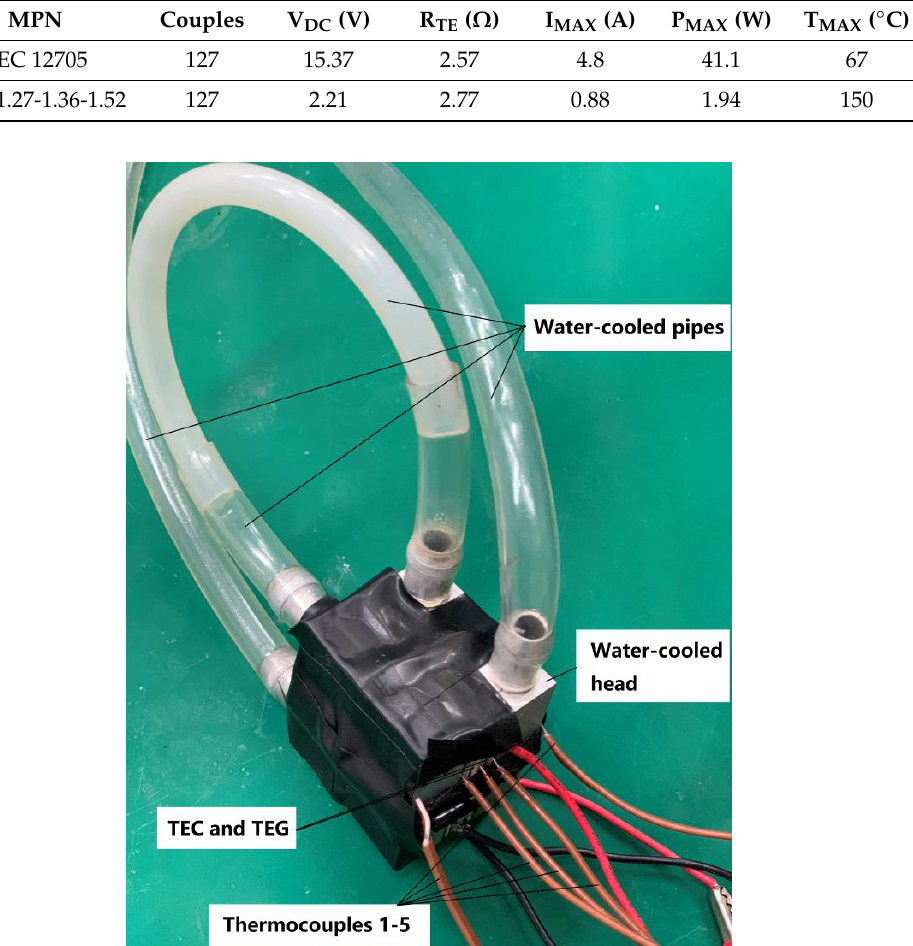
Figure 3. Detailed picture depicting position of thermocouples and thermoelectric cooler (TEC) and thermoelectric generator (TEG) modules.